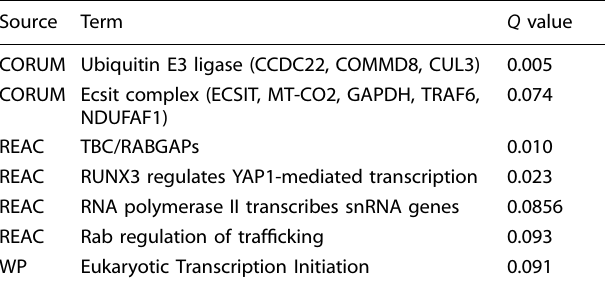
Table 4. Pathway enrichment analysis of red gene module for drug treatment in